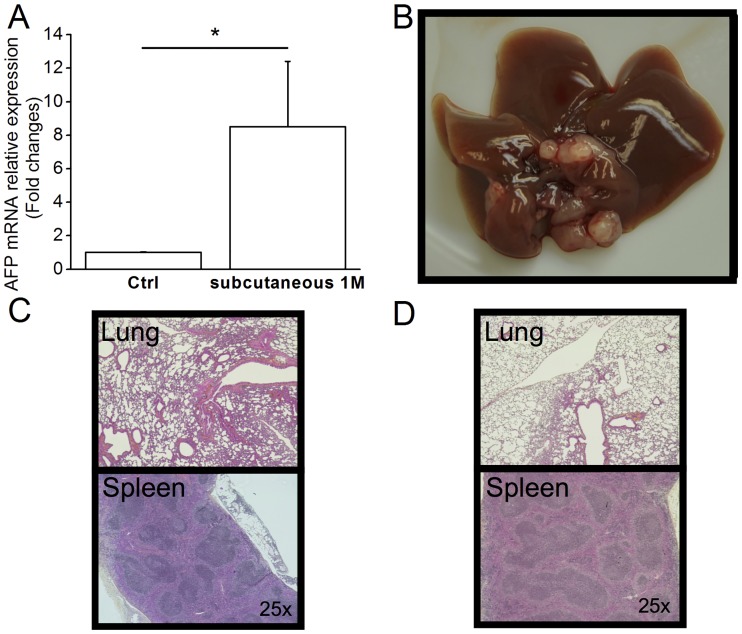
Dt81Hepa1-6 cells are specific to the liver.A suspension of 1M Dt81Hepa1-6 cells was injected subcutaneously (SC) in the left flank of C57BL/6 mice and animals were sacrificed after 28 days. (A) AFP mRNA relative expression in control and SC injected C57BL/6 mice. (B) Whole liver photographs at time of sacrifice. HPS-stained slices representative microphotographs of (C) lungs and spleen after SC injection and (D) Lungs and spleen after IS injection. Representative microphotographs were obtained at 100x magnification. (*P<0.05).